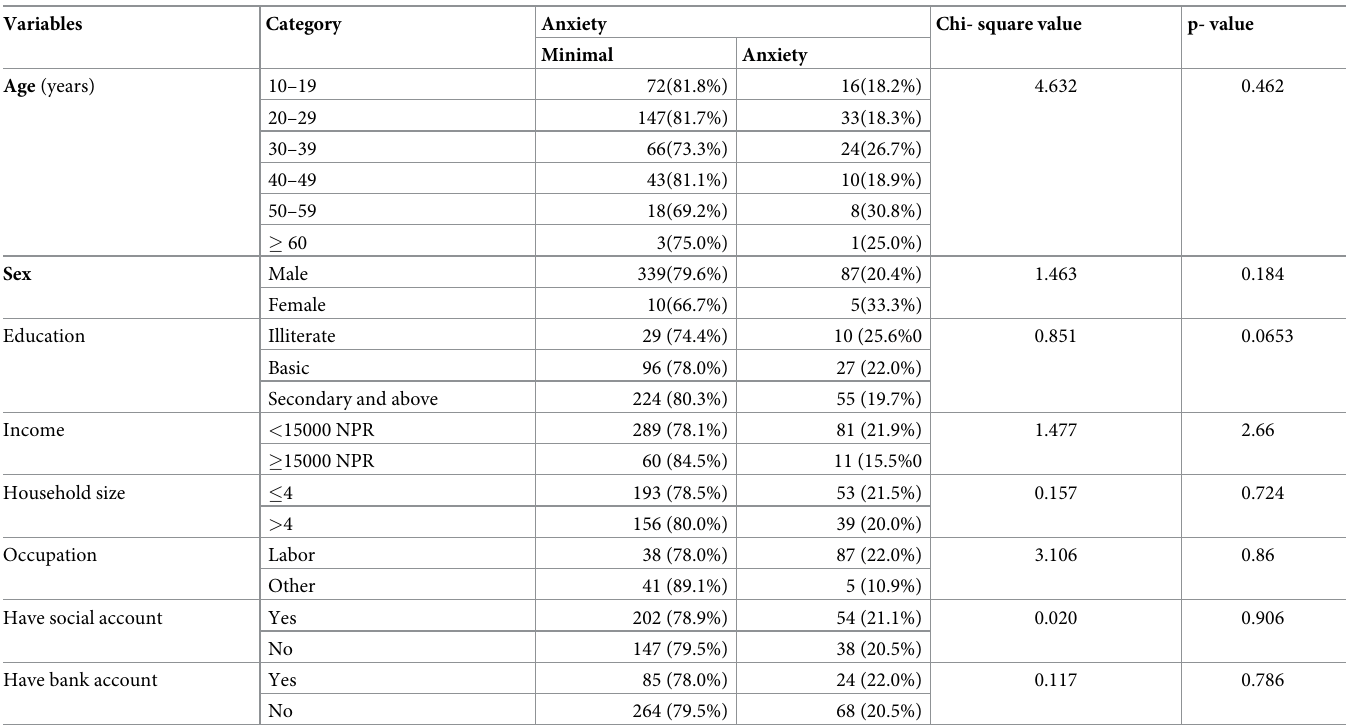
Table 4. Relationship between anxiety and independent variables.